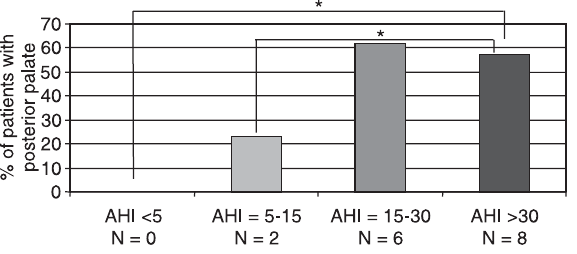
Figure 3. Upper airway anatomic abnormality (posterior palate) and severity of obstructive sleep apnea syndrome in class III obese patients. AHI = apnea-hypopnea index. *P = 0.03 (chi- square test).